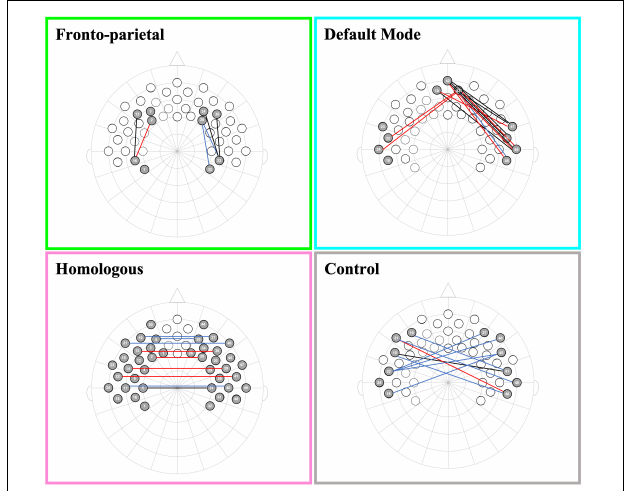
FIGURE 2 | Channel pair connectivity by network. This figure shows the channel pairs with functional connections that were significantly different from zero for each network. Connections in red, blue, and black represent significant changes between the channels for oxyHb, deoxyHb, and both oxy and deoxyHb,